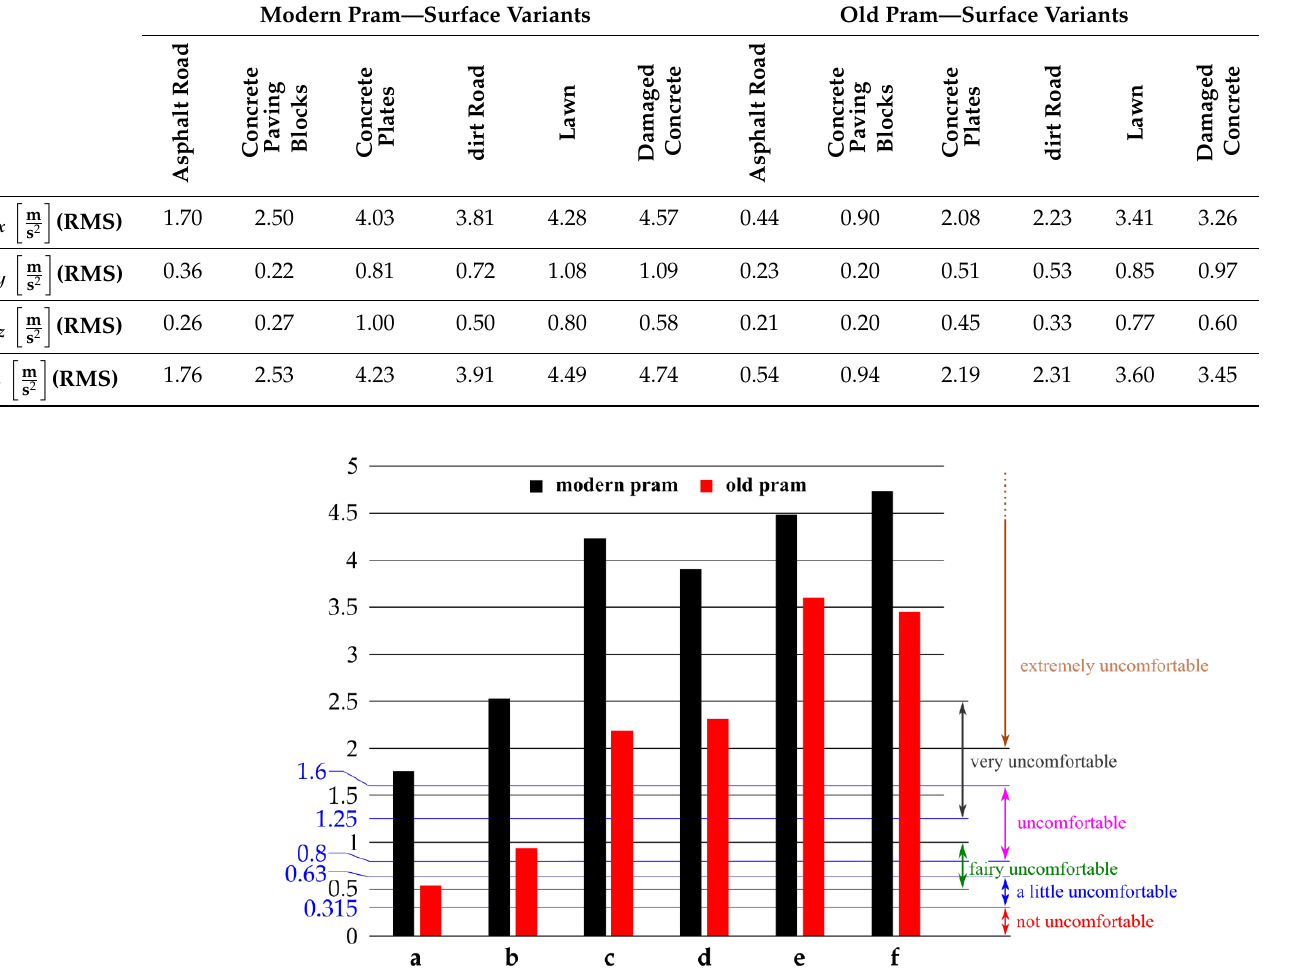
Table 4. Weighted RMS acceleration values (calculated in accordance with ISO 2631-1:1997 [18]) applied to the weight placed in the space provided for a child in the tested perambulators.